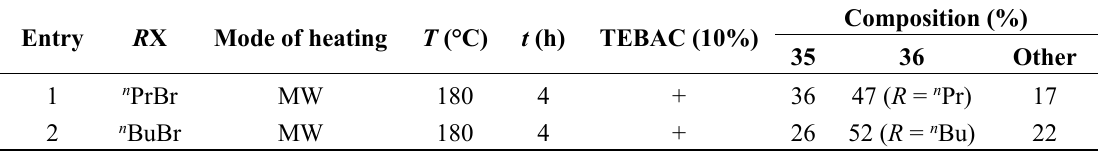
Table 9. Propylation and butylation of bis(diphenylphosphinoyl)methane ( 35 ) in the presence Cs 2 CO 3 and TEBAC in acetonitrile under MW